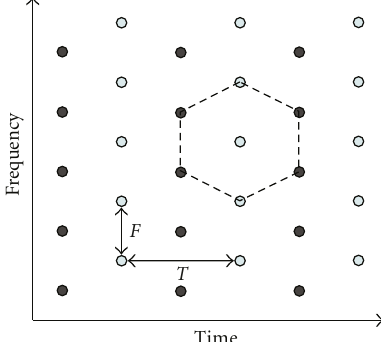
Figure 1: Partition of the hexagonal lattice into a